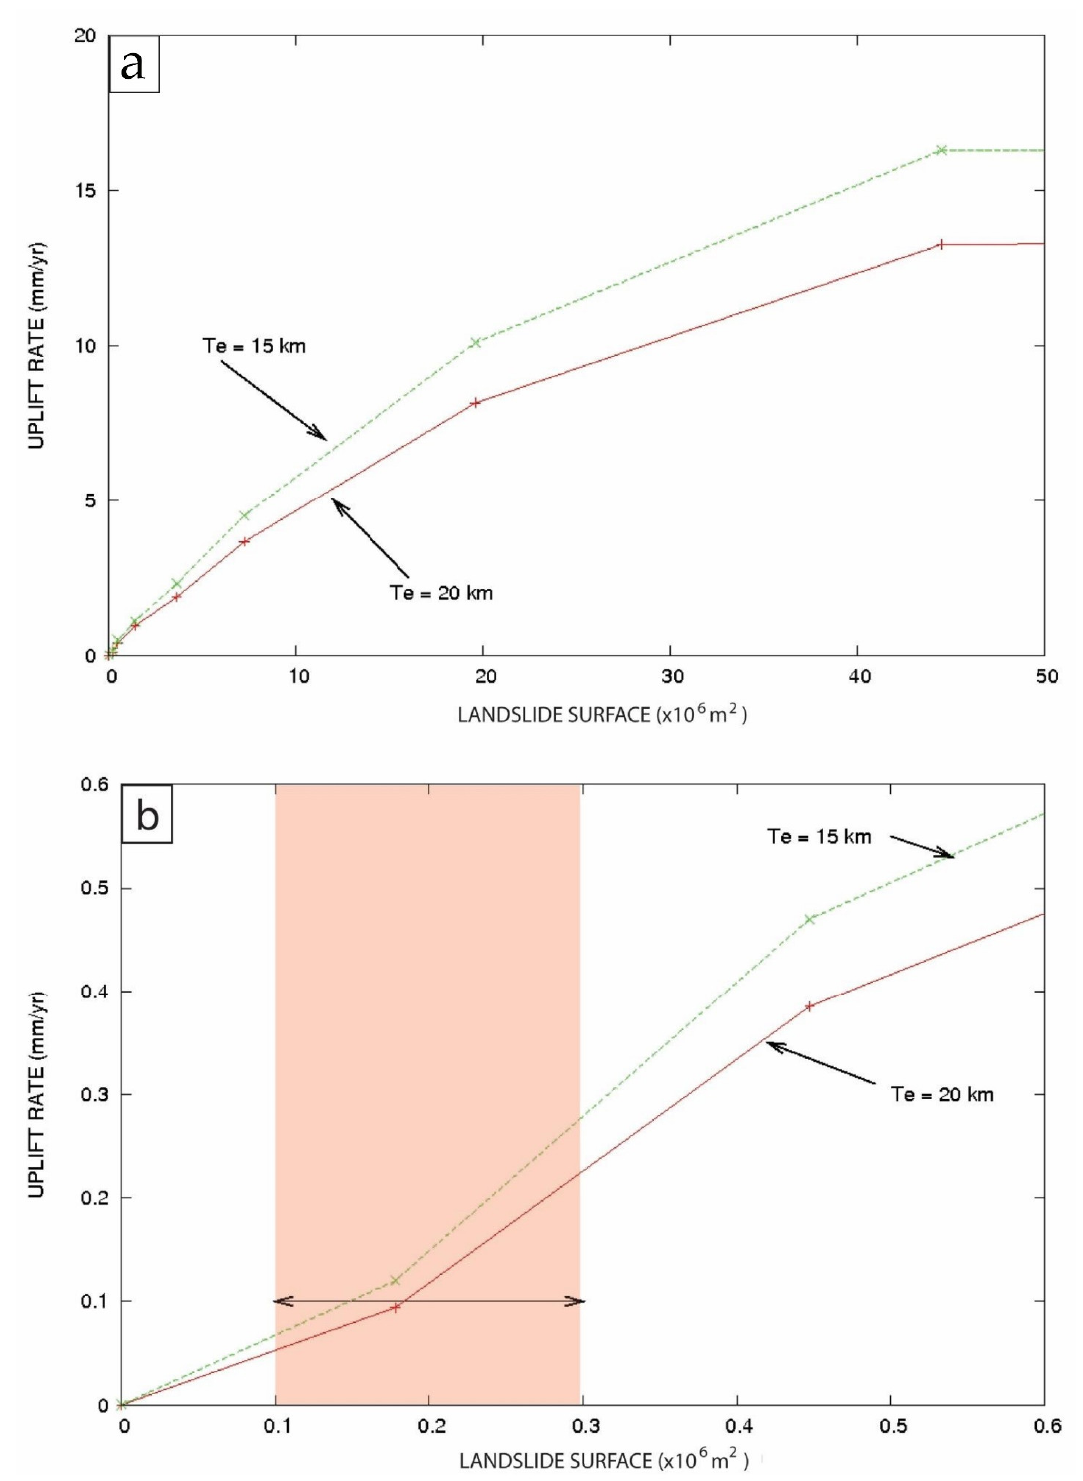
Figure 5. Vertical motion rate after an abrupt mass unloading due to isostatic adjustment. ( a ) Influence of the cross-sectional surface of the abrupt mass unloading on the uplift rate considering that the isostatic rebound takes place in 10 kyr. ( b ) Detail of the uplift rate for abrupt mass unloading cross-sectional surfaces < 0.6 × 10 6 m 2 . An uplift rate of 0.1 mm/yr, equivalent to the variation in the subsidence rate in Tahiti, is highlighted by a double arrow. The abrupt mass unloading able to cause an uplift of 0.1 mm/yr ranges from 0.1 × 10 6 to 0.3 × 10 6 m 2